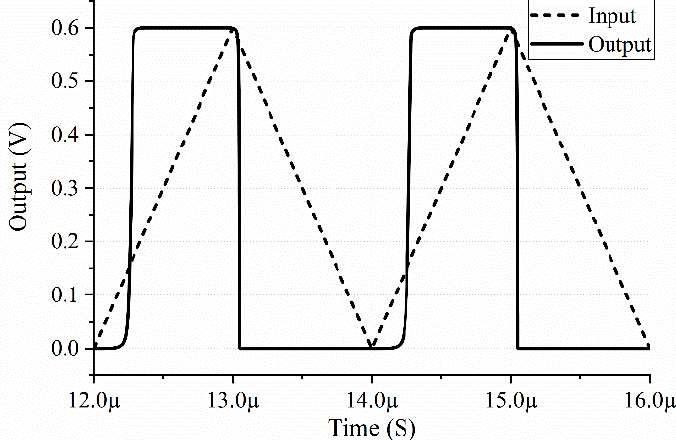
Figure 8. Time-domain response of the designed Schmitt trigger circuit to 500 kHz triangular input signal.